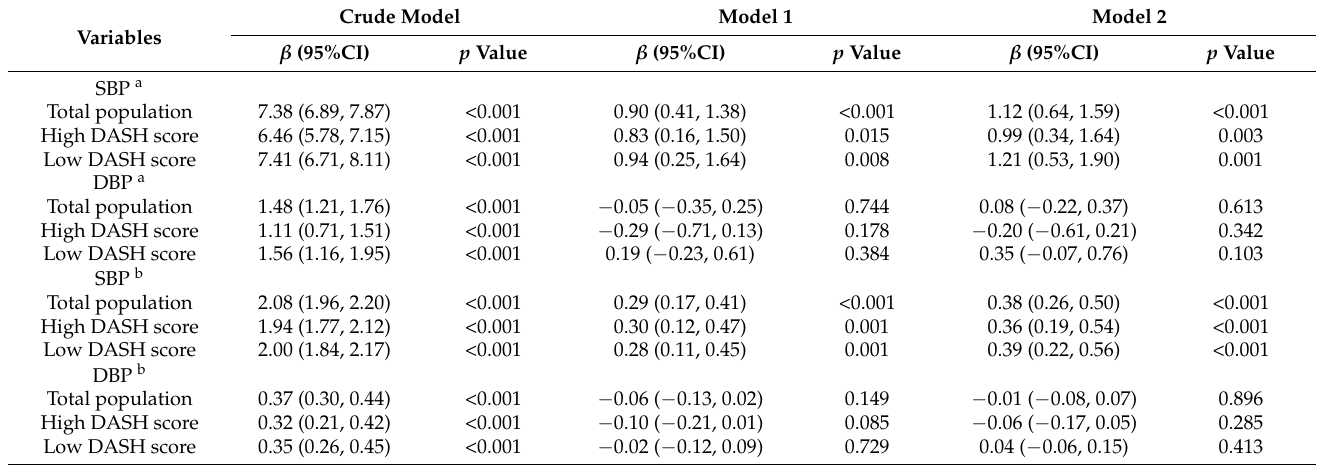
Table 3. Associations between menarche age and